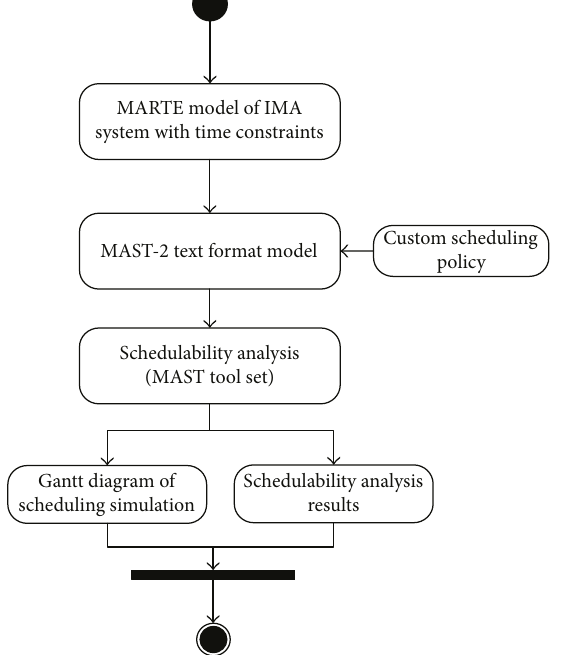
Figure 16: Process fl ow of IMA system schedulability veri fi